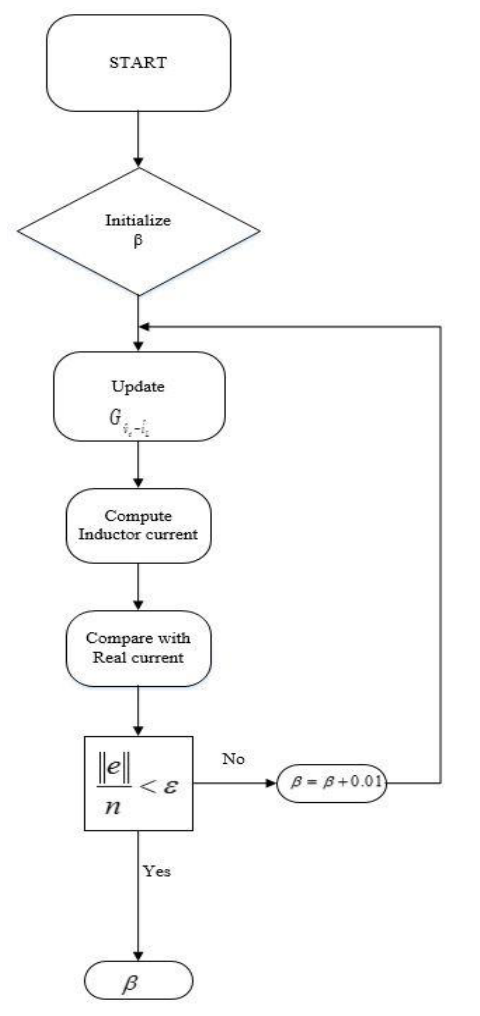
Figure 9. Proposed method flowchart for finding  .